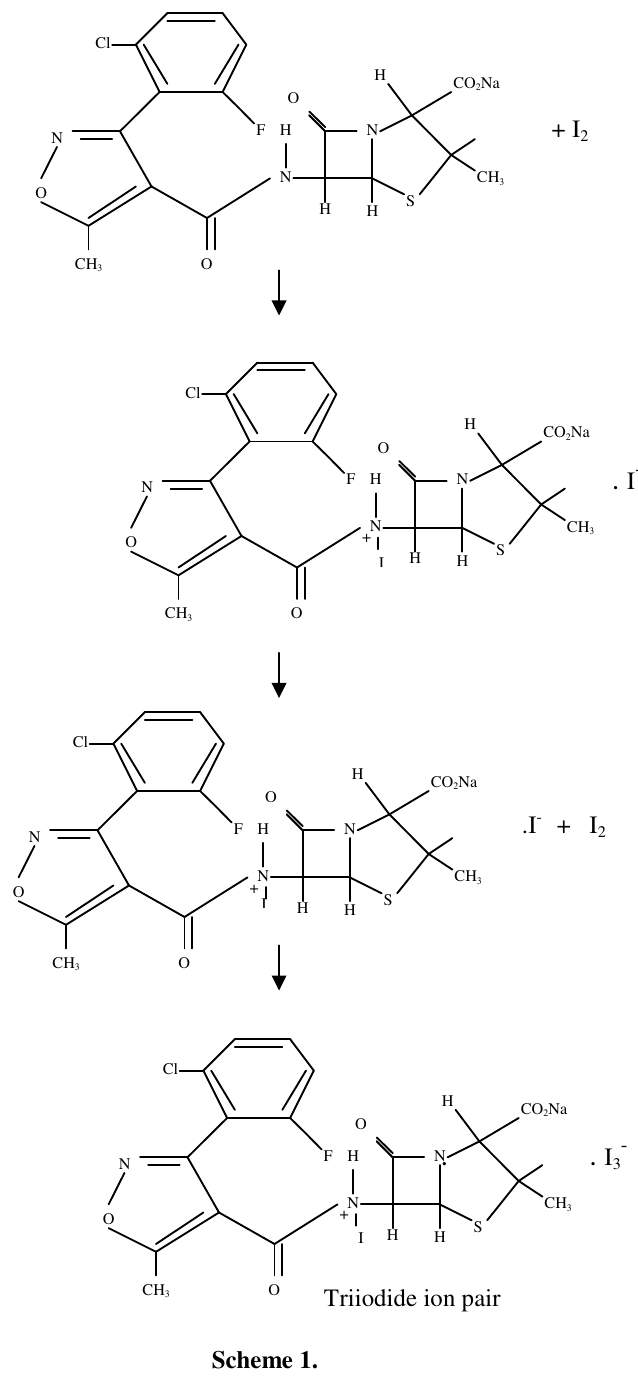
Triiodide ion pair Scheme